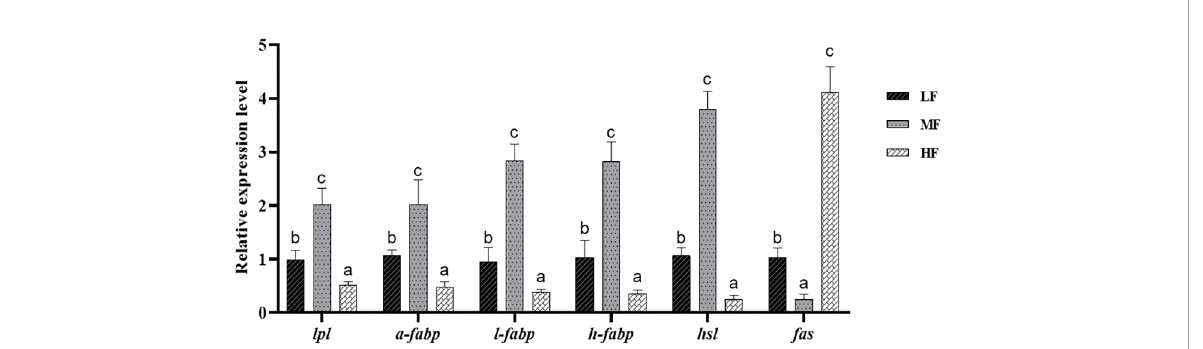
FIGURE 2 Effect of dietary lipid levels on relative expression of hepatic lipid metabolism-related genes of hybrid grouper. Values are means ± SEM (n = 3). Different letters assigned to the bars represent signi fi cant differences using Tukey ’ s test ( P < 0.05). lpl , lipoprotein lipase; a-fabp , adipocyte-type fatty acid-binding protein; l-fabp , liver-type fatty acid-binding protein; h-fabp , heart-type fatty acid-binding protein; hsl , hormone-sensitive triglyceride lipase; fas , fatty acid